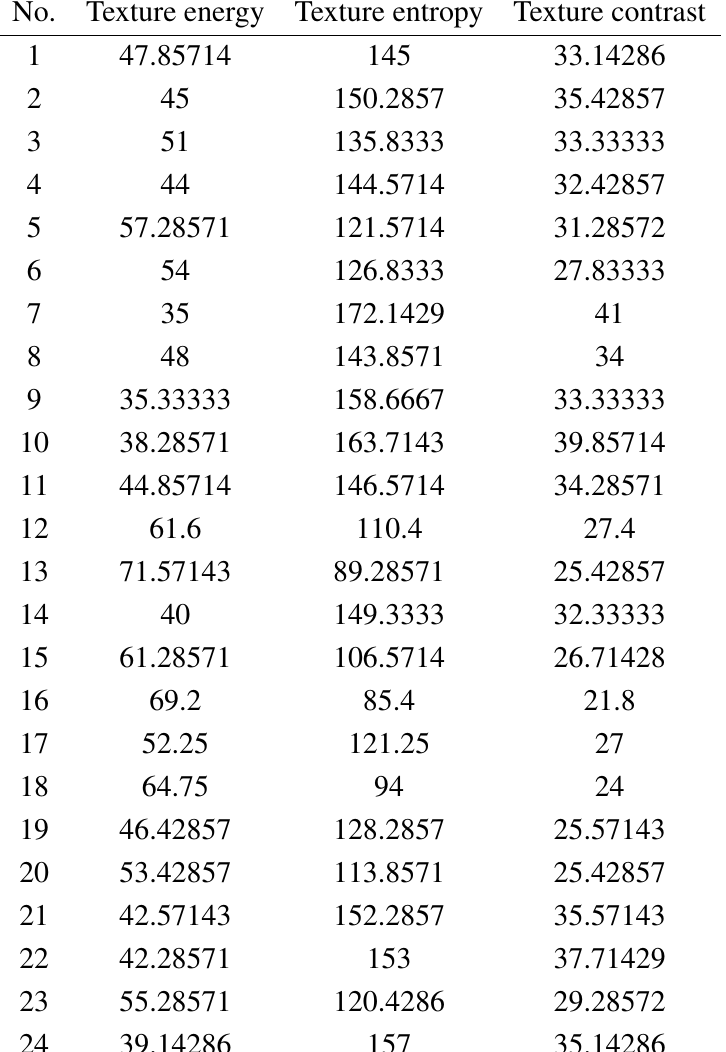
Table 3. Texture features of some tobacco leaves (Dimensionless unit).